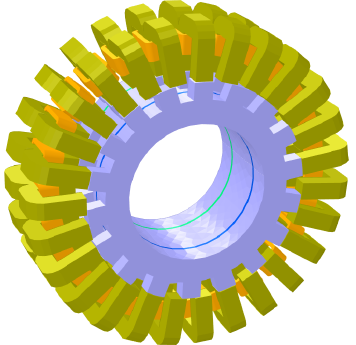
Figure 3. 3D-FEM model of the hybrid rotor machine.